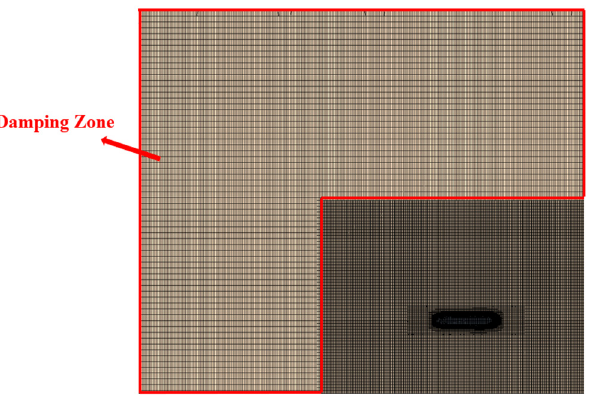
Figure 11. Grid diagram of the damping zone of the computing domain.